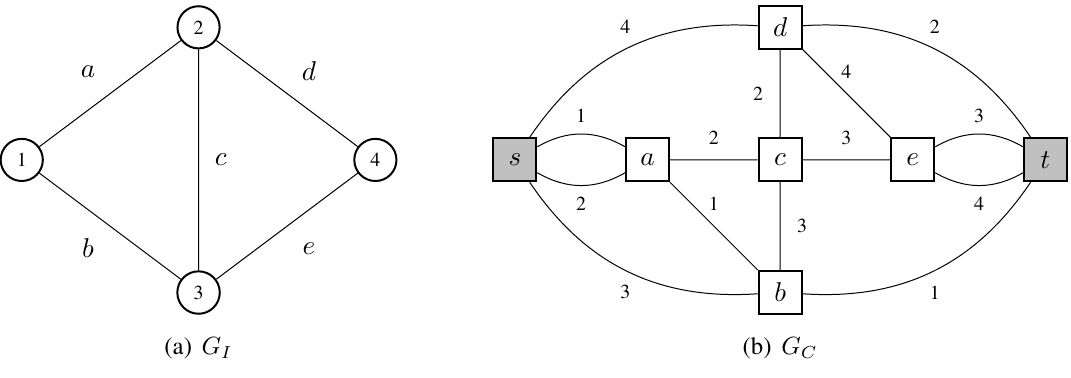
G Figure 1. An example of a graph G I and the edge-colored graph C associated with it. For convenience, we labelled the edges of G I such as they correspond to the vertices in G C . The colors of the edges in G C are indicated by numbers placed near the edges, while the two distinguished vertices s and t are highlighted in grey. The order Π E of the edges of G I is I simply the lexicographic order of their